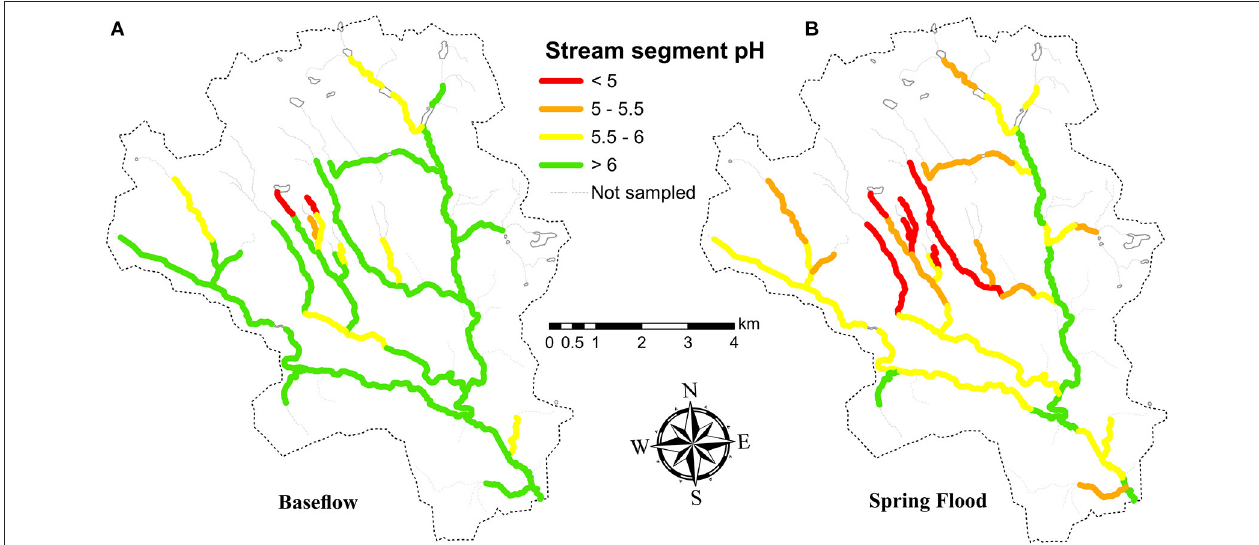
FIGURE 2 | Spatial patterns in acidity in the stream network based on (A) pH at winter baseflow (B) pH at spring flood. pH values from chemistry sampling sites were assigned to stream segments extending up to the halfway point between sites, or for headwater sites, to half the distance of the furthest extent of the stream. Values were not extended beyond stream junctions. Panel B after Laudon and Buffam